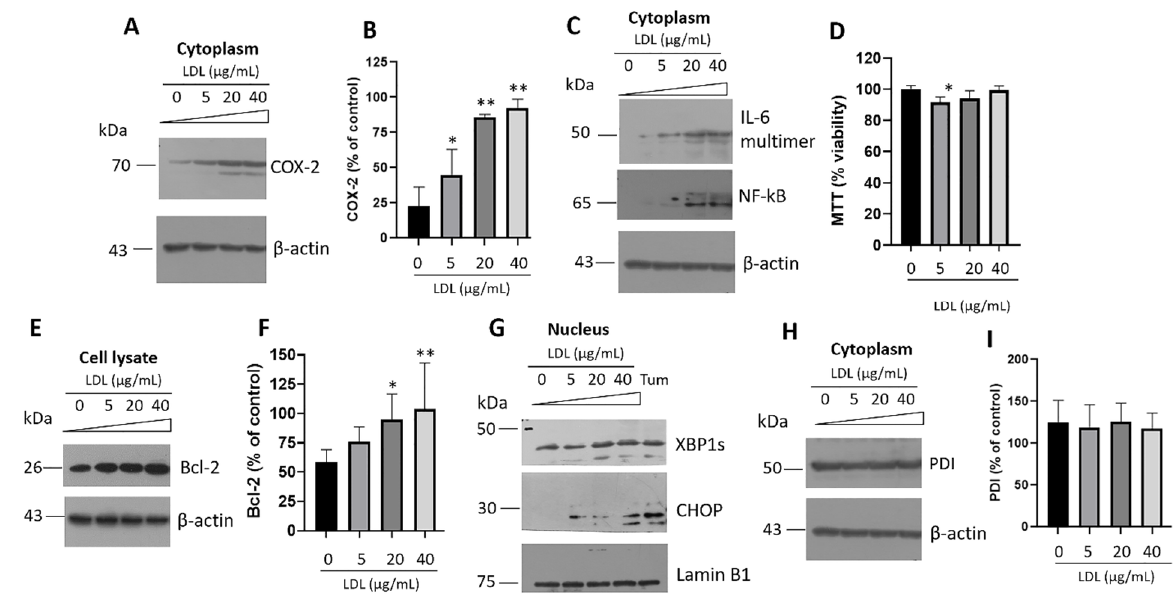
Figure 4. In β-cells, activation of UPR induced by LDL is connected with inflammatory markers. ( A ) COX-2 expression under the LDL treatment (0–40 µg/mL) for 20 h in cytoplasm. Tunicamycin (Tum, 1 µg/mL) was used as an ER-stress inducer. ( B ) Densitometry analysis of COX-2, results are reported as mean ± SD ( n = 3) and expressed as % of control, * p < 0.1, ** p < 0.0005. ( C ) IL-6 and NF-κB expression under LDL increasing concentrations. ( D ) Effect of LDL treatment (0–40 µg/mL) on β- cell viability, results are reported as mean ± SD ( n = 6), * p < 0.05. ( E ) Under the same conditions, expression of apoptosis regulator, Bcl-2; ( F ) quantitative characterization of the Bcl-2 expression ( n = 3, mean ± SD), * p < 0.05, ** p < 0.005. ( G ) Western blot of the UPR targets XBP1s and CHOP under LDL stimuli (0–40 µg/mL) in nucleus isolates. Lamin B1 was used as a loading control. Tunicamycin (Tum) was used as a control (1 µg/mL). ( H ) PDI expression levels under the LDL treatment. ( I ) Densitometry analysis of PDI, results are reported as mean ± SD ( n = 3) and expressed as % of con- trol. In panels A, C, E, and H, β-actin was used as a loading control.